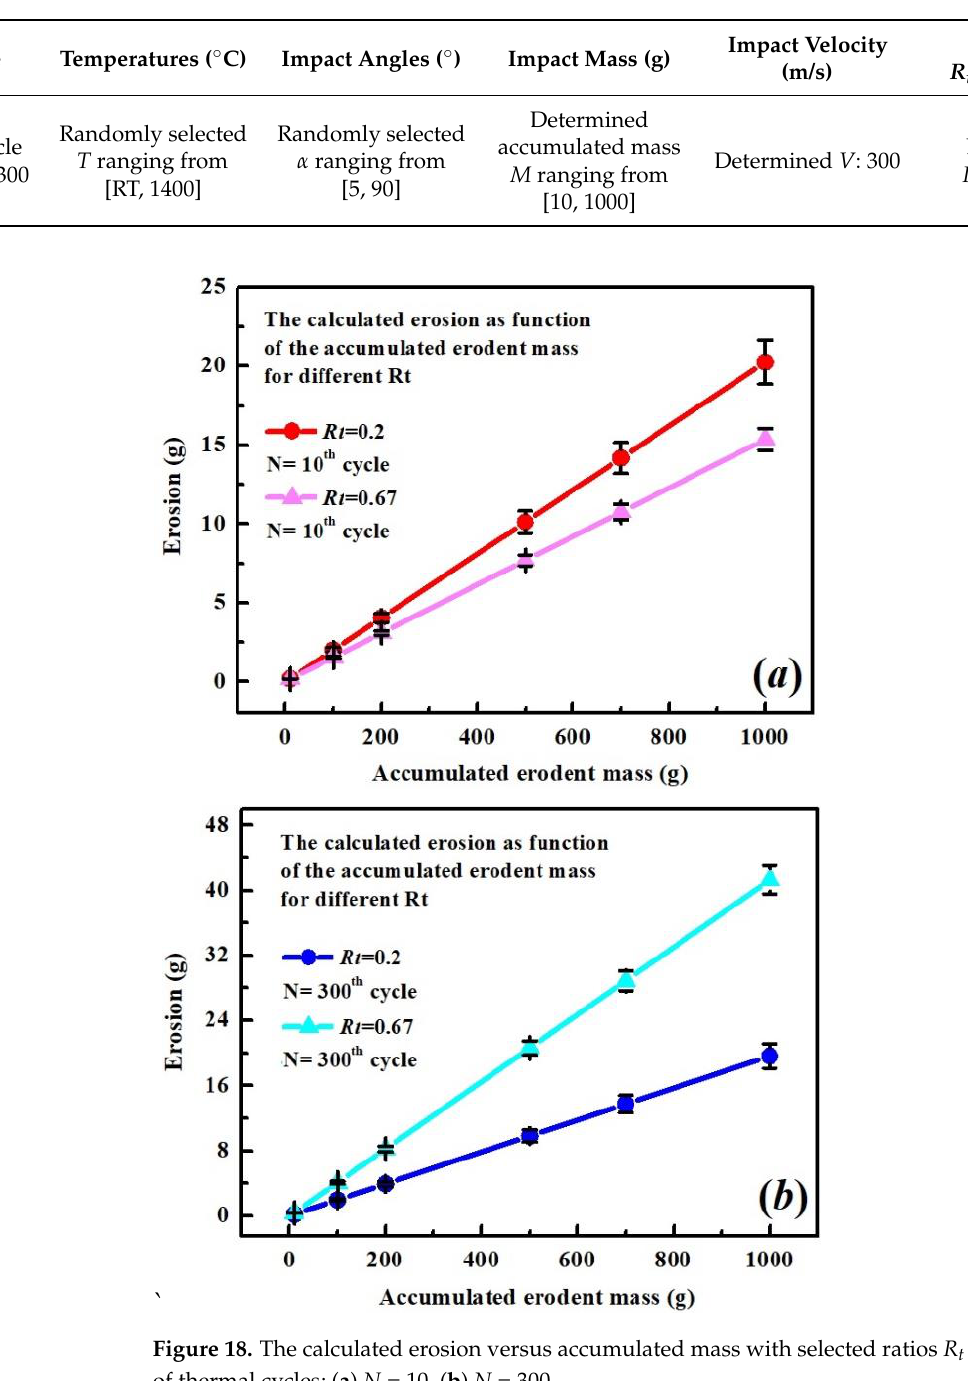
Table 10. Parameters used to calculate erosion rates versus accumulated mass with selected high- temperature dwell period and thermal cycles.